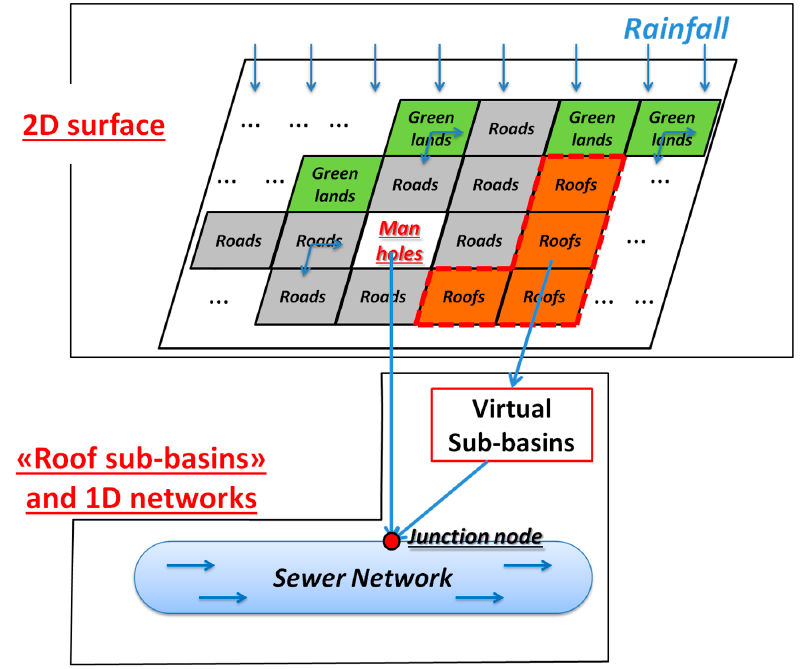
Figure 1. The scheme of the physically ‐ based 2D/1D modelling platform TRENOE.